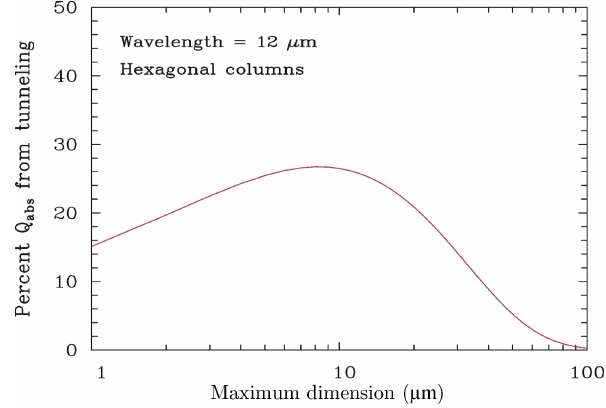
Figure 1. Percent contribution of wave resonance absorption to the overall absorption efficiency at 12µm wavelength as a function of maximum dimension D for hexagonal columns, as estimated by the MADA. It is decreasing to below 10% of its maximum for sizes larger than about